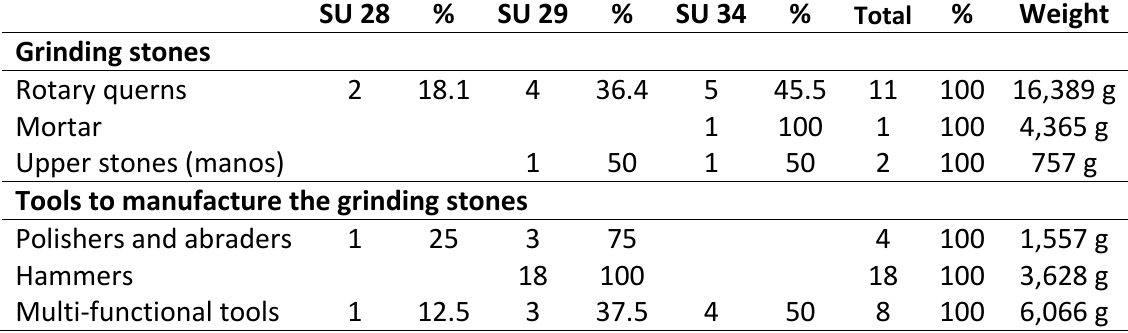
Table 4. Grinding stones and the tools to make them collected in different stratigraphic units (SU) at the Cardones workshop.